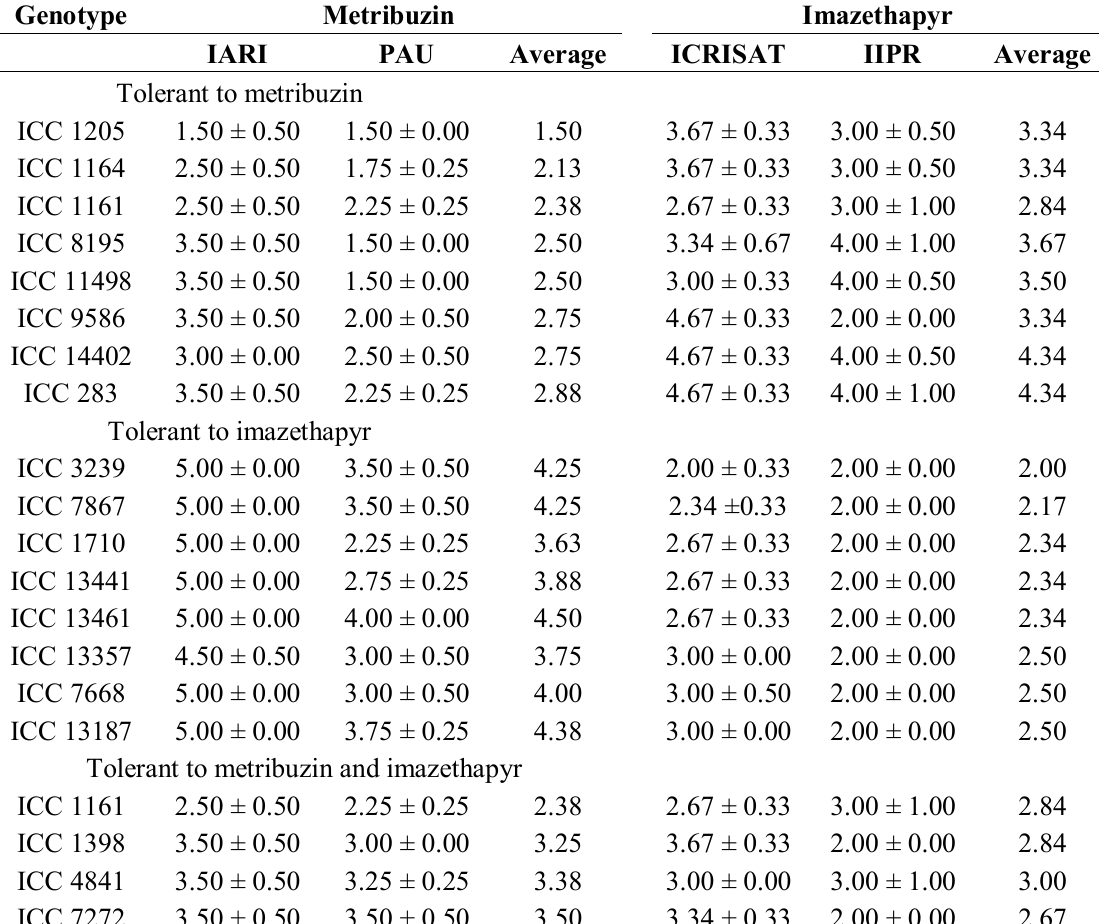
Table 1. Top ranking tolerant and sensitive chickpea genotypes for herbicides metribuzin and imazethapyr (Mean score ± SE on a scale from 1 to 5, where 1 = highly tolerant and 5 = highly